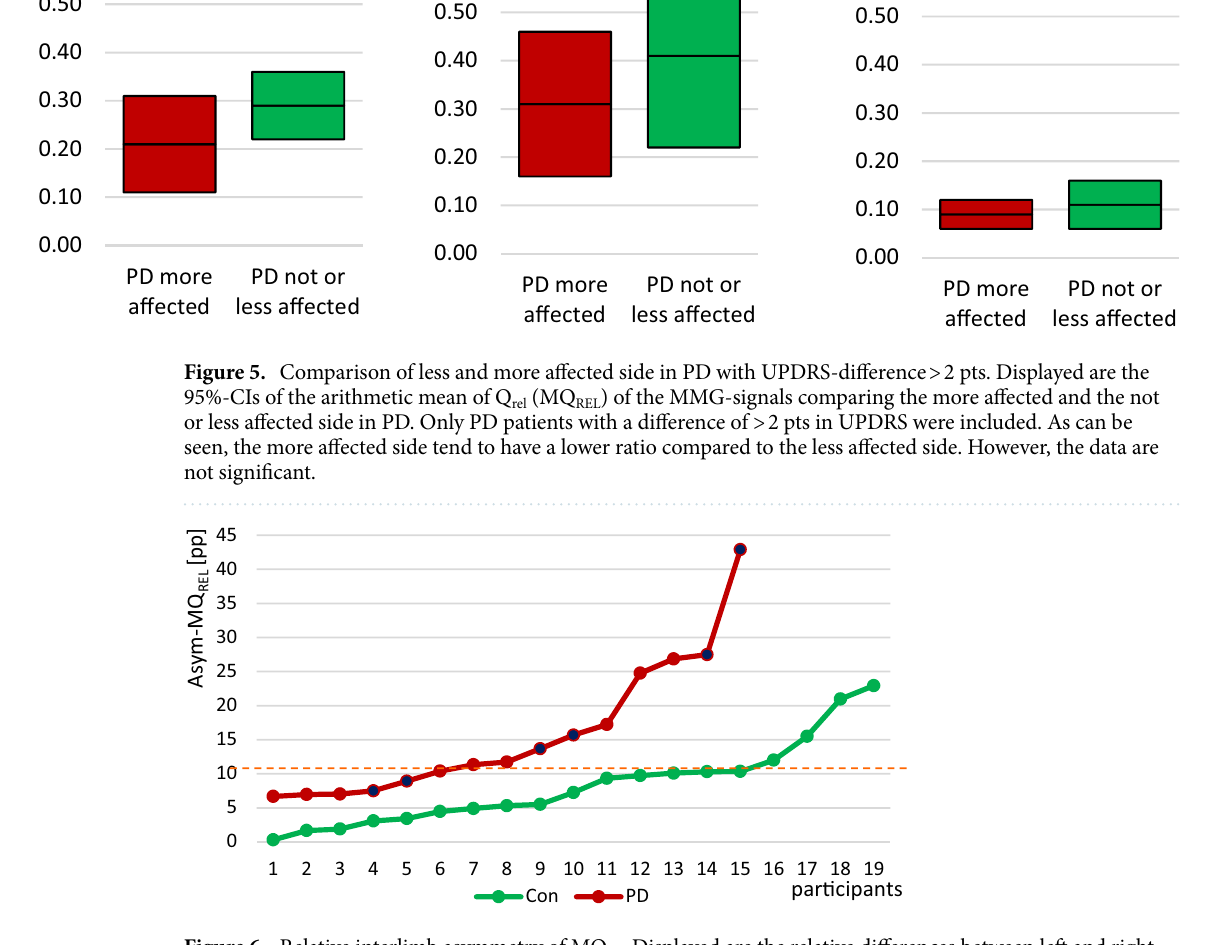
ACC‑signal. The slope of amplitude maxima of the ACC-signal differed significantly between PD and Con with regard to the M and CV of the five trials. The M of slope of PD was significantly higher compared to the Con group (M slope: U = 2.297, p = 0.022, r = 0.33, n = 48), whereas the CV of slope was significantly lower in PD ( U = -2.876, p = 0.004, r = 0.42) (Fig. 8). Significant interlimb asymmetries did not exist (Table 4). UPDRS. The UPDRS scores for the healthy controls were 0 in all cases. In PD patients they ranged from 0 to 17 points for the right and from 0 to 11 points for the left side and showed no statistical differences between left and right side ( W = 31.5, p = 0.103). The interlimb differences ranged from 0 to 8 points. Eight out of the 22 patients showed a difference of more than 2 points. Six patients exhibited severer symptoms in the neurological examination on the right side, two on the left side. In comparing the UPDRS and the own assessment of patients with respect to the more affected side, nine cases indicated a different estimation. However, only in three of those patients the UPDRS difference between left and right side was higher than 2 points. In the remaining five patients with an UPDRS difference higher than 2 pts, the own assessment and the esti- mation using the UPDRS agreed. The UPDRS score had no significant influence on all considered parameters ( p > 0.05).